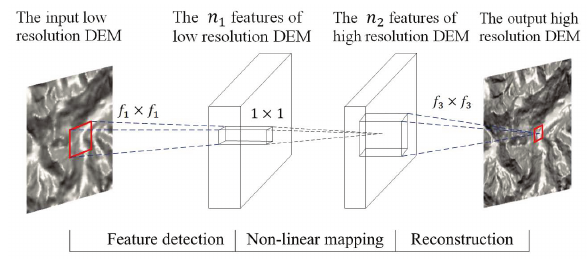
Figure 1. The CNN for super